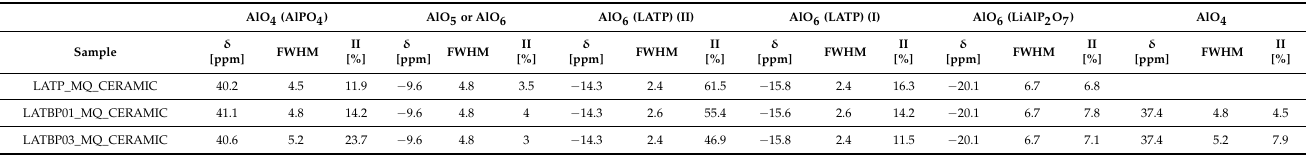
Table 4. Relative integrated intensities (II), full widths at maximum height (FWHM) and isotropic chemical shifts ( δ ) of the line-shapes used to simulate 27 Al MAS NMR spectra shown in Figure 10.